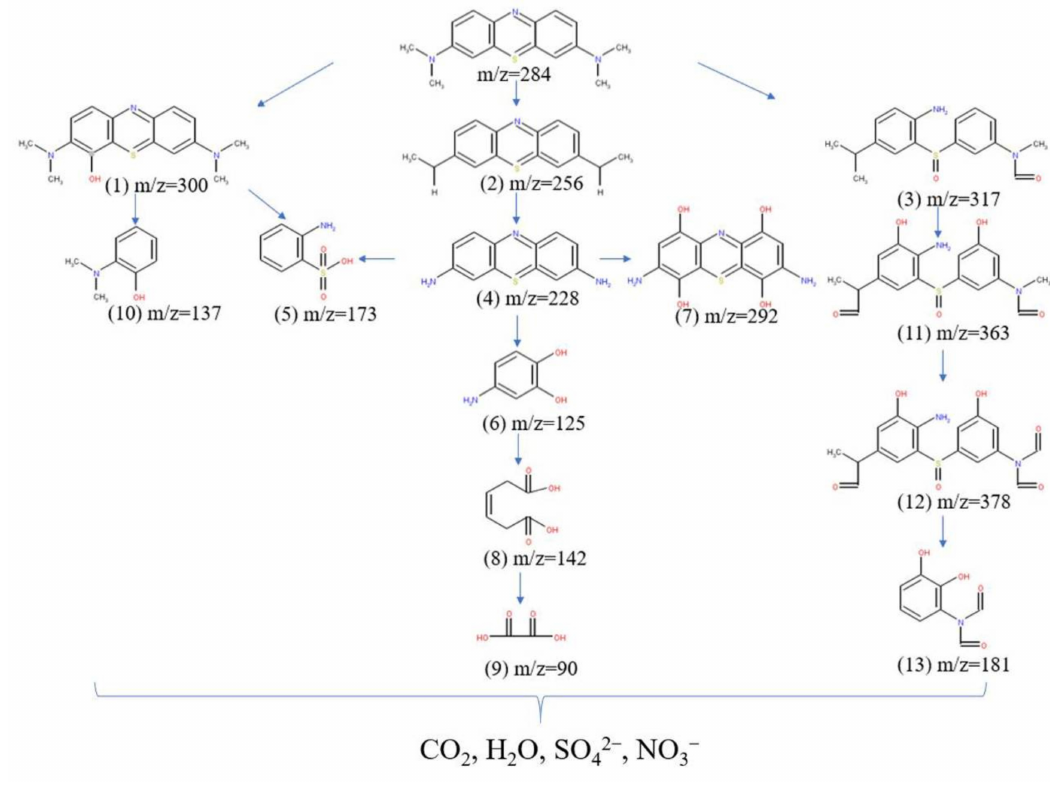
Figure 5. Possible degradation pathway in EC/Fe 2+